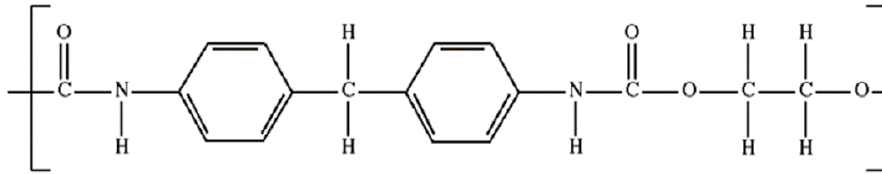
Figure 1. General formula of polymer.